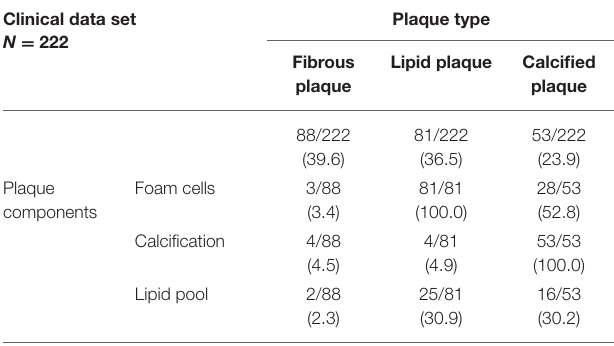
TABLE 2 | Clinical data set ( n = 222 OCT frames).